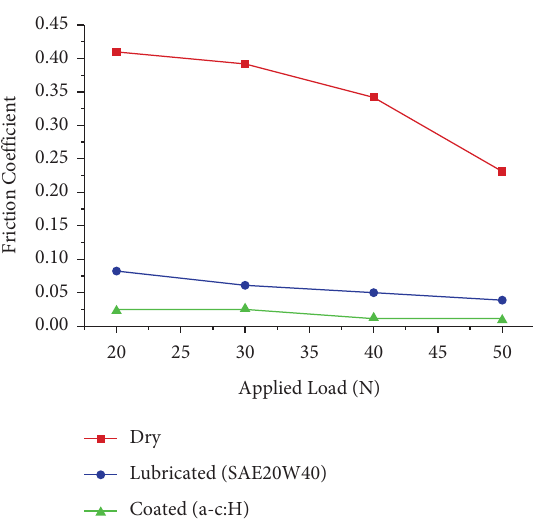
Figure 9: Efect of load vs. coefcient of friction.